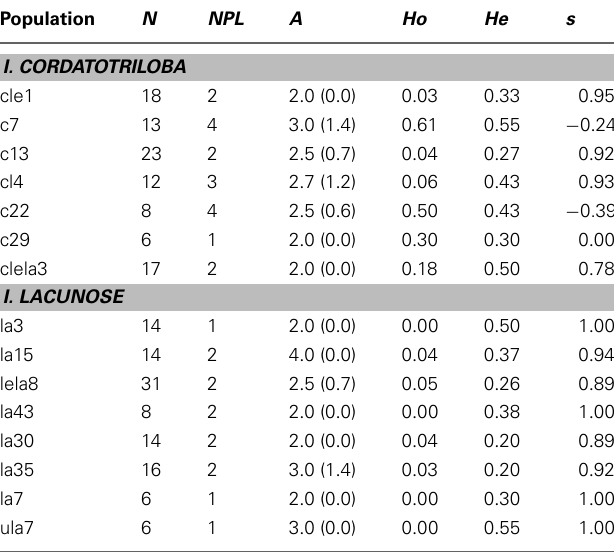
Table 1 | Measures of genetic diversity and selfing rate for 7 populations of I. cordatotriloba and 8 populations of I. lacunosa from North Carolina and South